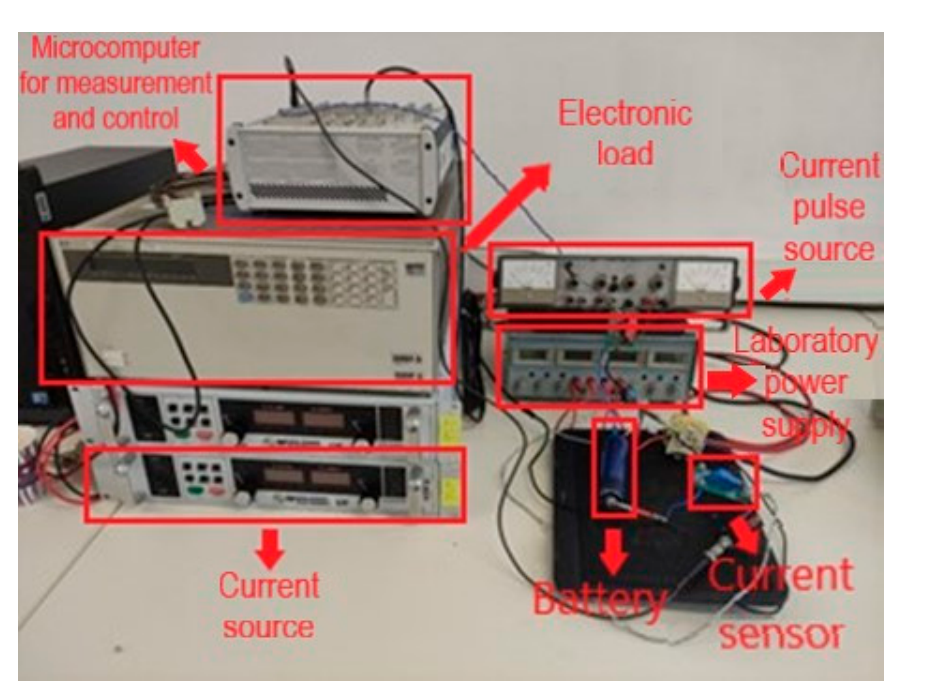
Figure 5. Experimental setup.